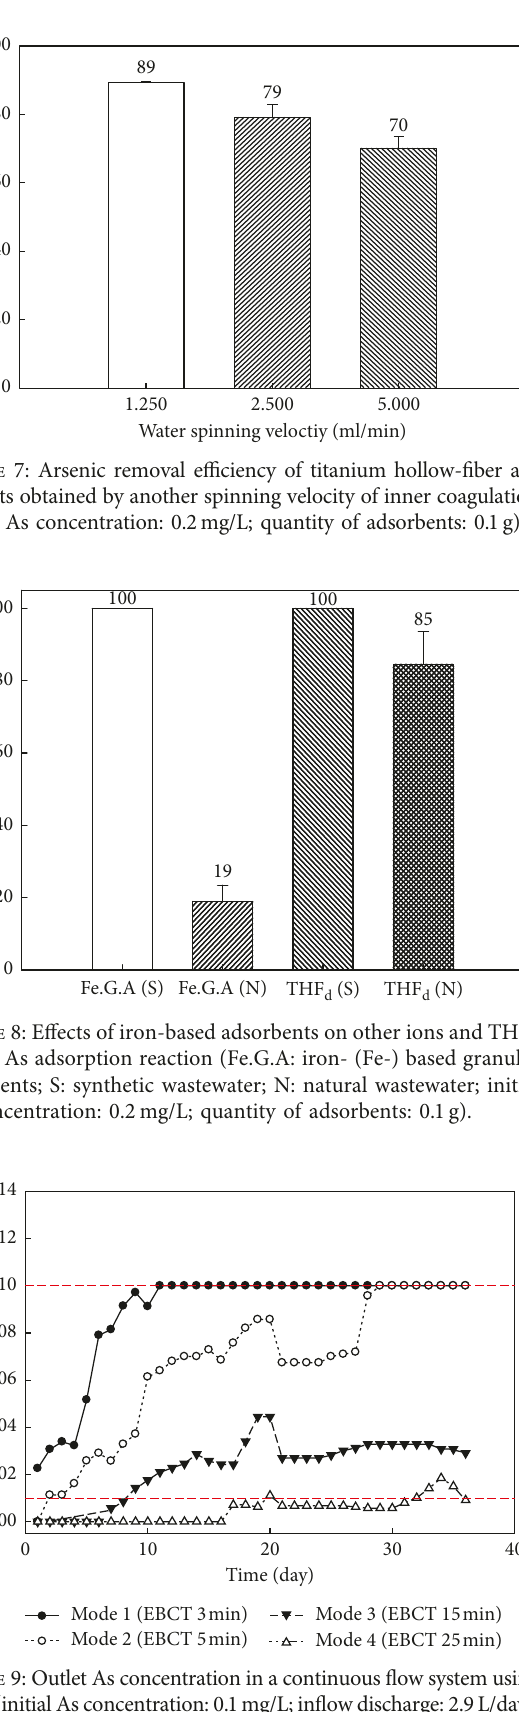
Figure 9: Outlet As concentration in a continuous flow system using THF d (initial As concentration: 0.1mg/L; inflow discharge: 2.9L/day).